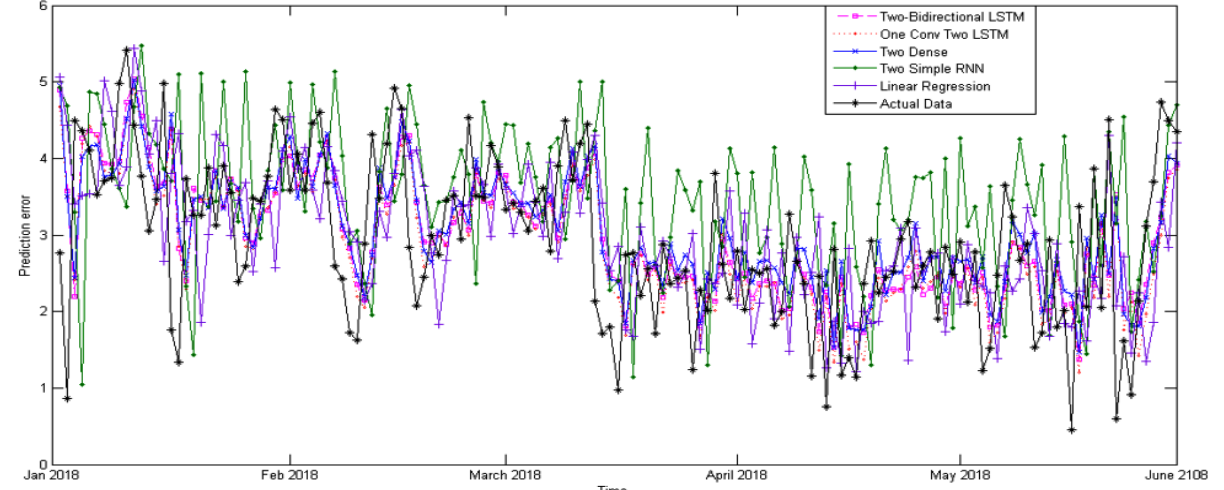
Figure 6. Prediction plot of wind speed data of considered model in Salem Dataset from Jan 2018 to June